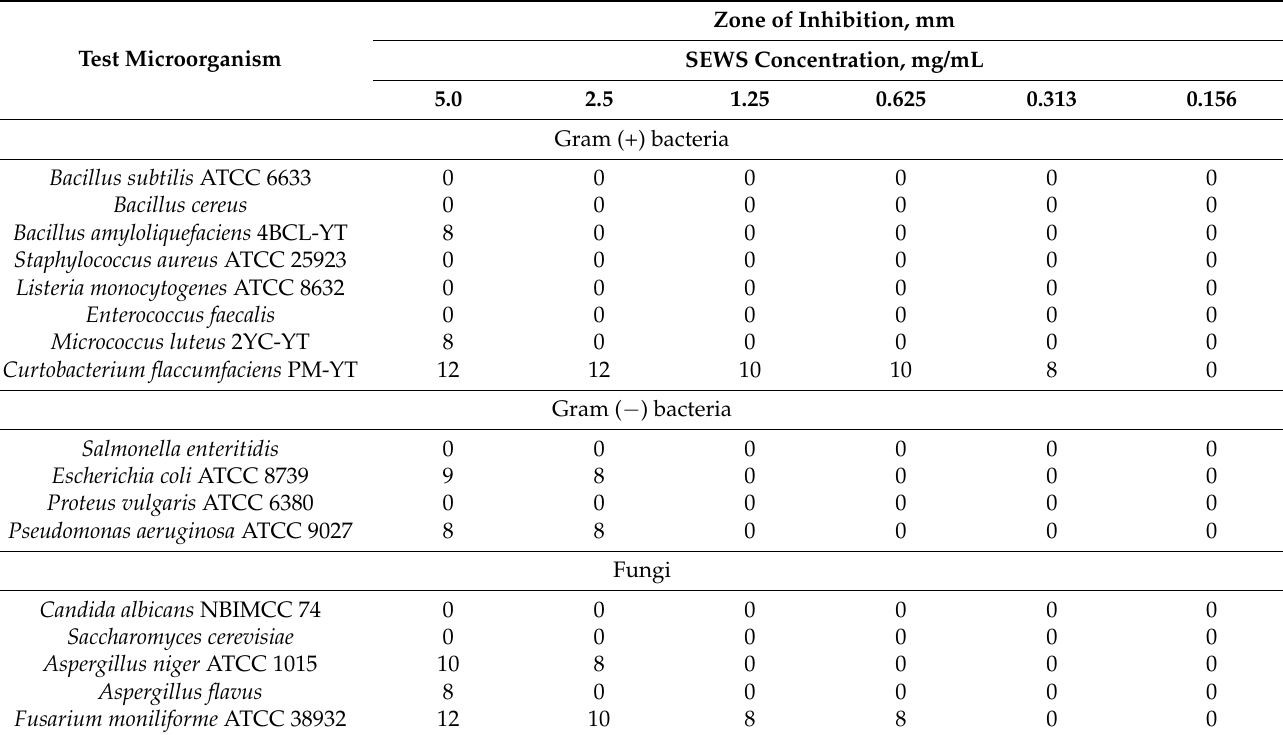
Zone of Inhibition,